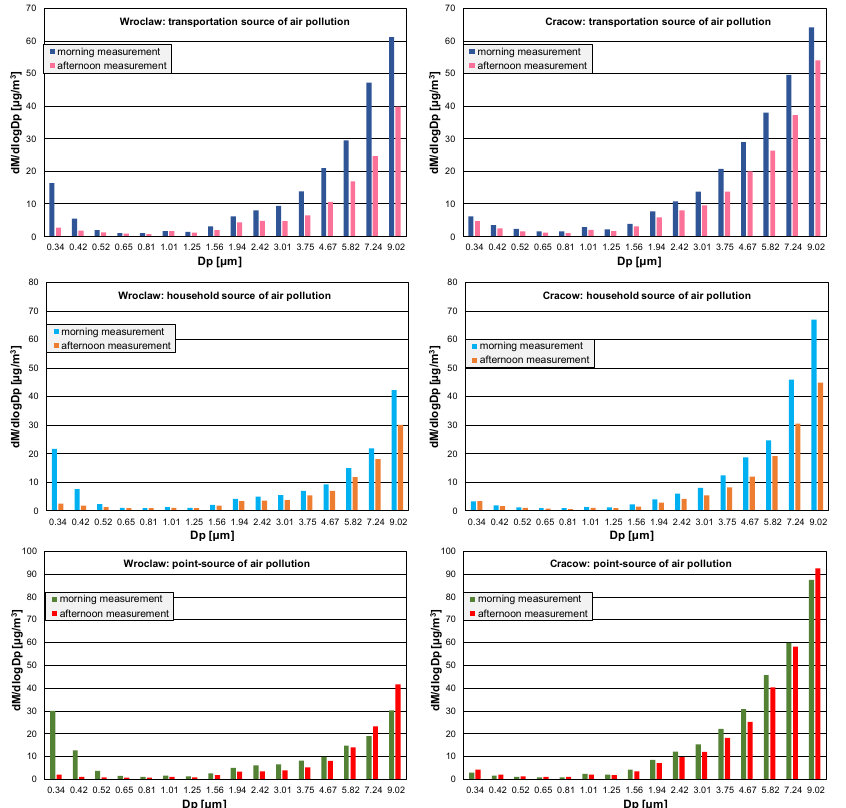
Figure 3. Particulate mass (PM) distribution in Wroclaw and Cracow. A more detailed description is provided in Figure 4 which shows the share percentage of each particle diameter in the test in each type of immission source. The green color indicates the shares up to 5%, yellow the range between 5% and 50%. Additionally, the range of the diameter of the largest particles number, and the share of particles with a diameter smaller than 1 μ m are shown in Table 2.